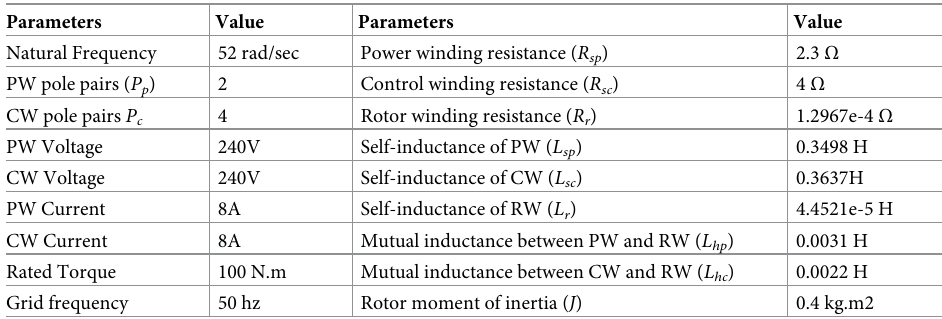
Table 3. Machine parameters.